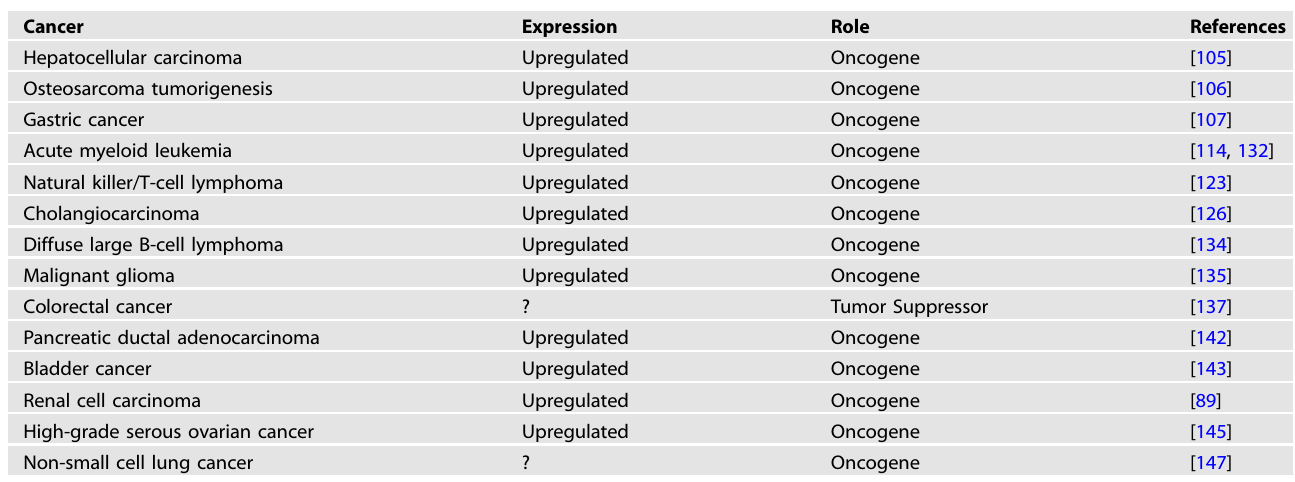
Table 2. WTAP expression in different